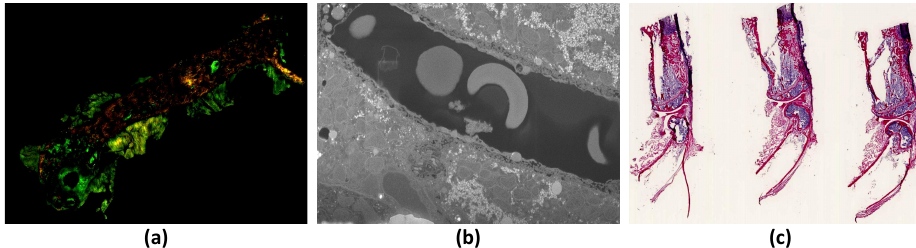
Figure 3. Samples of different microscope imaging modalities ( a ). Six-channel mouse bone tissue (left leg femur, infected treated unsuccessfully) ( S. aureus : Visualized in blue; RUNX2: Visualized in pink; nuclei: Visualized in green; actin cytoskeleton: Visualized in red; collagen (SHG 2 photon): Visualized in orange): Generated by Zeiss scanner, with the .czi extension ( b ) FIB-SEM sample image showing liver microvili: Generated by electron scanner, with the .tif extension ( c ). WSI sample image of mouse bone tissue (left leg femur, infected treated unsuccessfully): Generated by Hamamatsu scanner, with the .ndpi